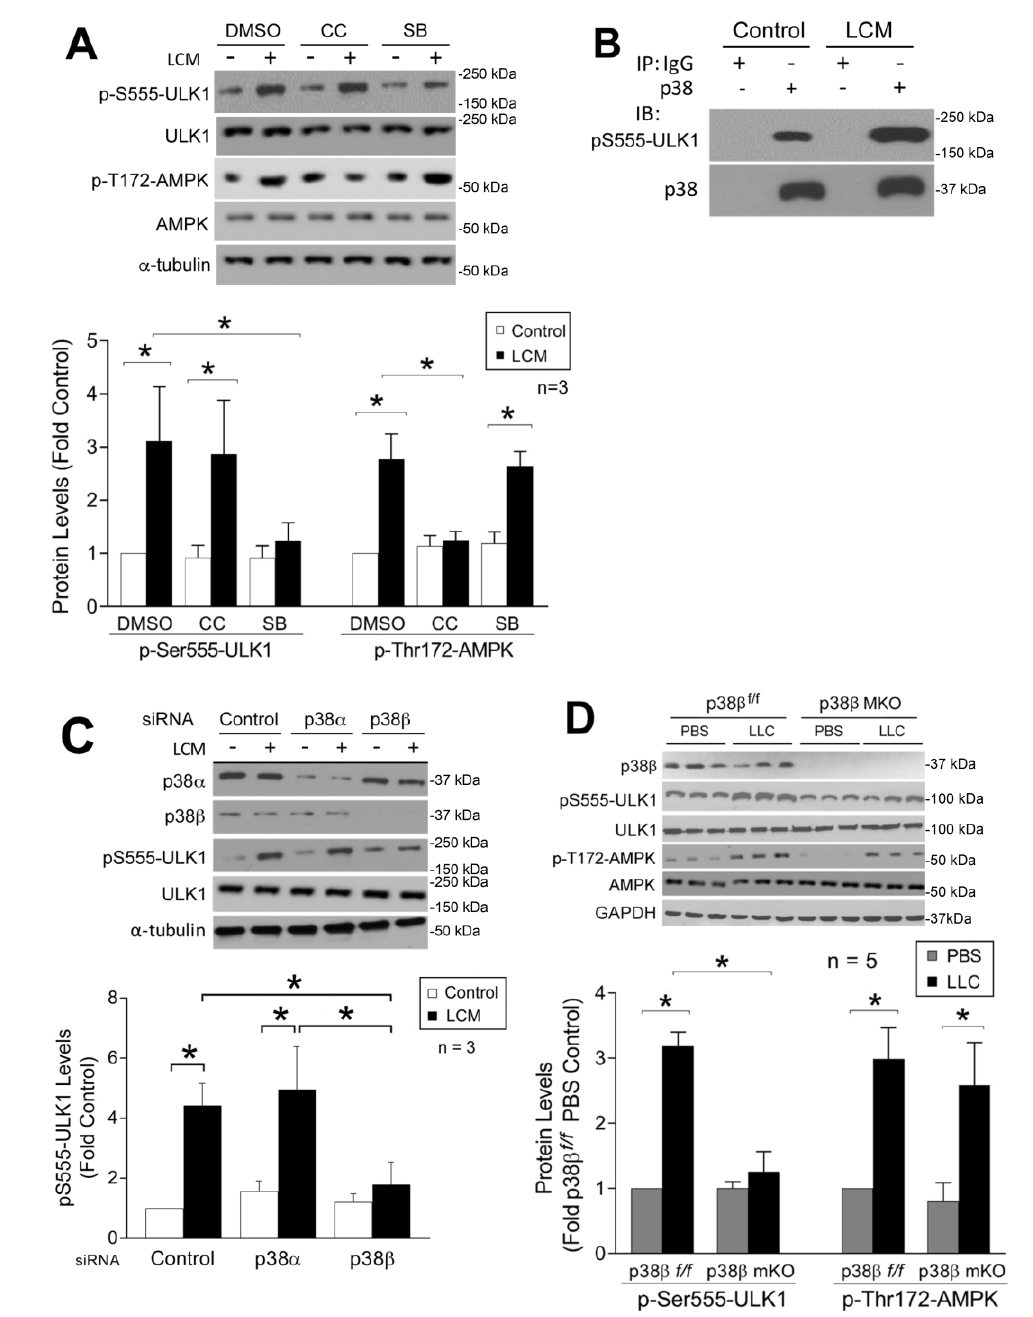
FIGURE 6: p38  MAPK activates ULK1 in skeletal muscle cells in response to tumor. (A) LCM stimulates ULK1 phosphorylation on Ser-555 in myotubes through p38 MAPK. C2C12 myotubes were pretreated with DMSO (0.1%, vehicle), compound C (CC, 10  M) or SB202190 (SB, 10  M) for 30 min, and then treated with LCM for 1 h. ULK1 phosphorylation state on Ser-555 and AMPK phosphorylation on Thr-172 in cell lysate were analyzed by Western blotting. (B) LCM stimulates p38 MAPK interaction with ULK1 in myotubes. C2C12 myotubes were treated with LCM for 1 h. Cell lysate was subjected to immunoprecipitation with pre-immune IgG or p38 MAPK-specific antibody. Precipi- tate was analyzed by Western blotting for p38 MAPK and pSer-555 ULK1. (C) LCM stimulation of ULK1 phosphorylation on Ser-555 in myo- tubes is mediated by p38  MAPK specifically. C2C12 myoblasts were transfected with control, p38  MAPK or p38  MAPK-specific siRNA. After differentiation for 96 h, myotubes were treated with LCM or control medium for 1 h. Knockdown of p38 MAPKs and phosphorylation of ULK1 on Ser-555 were analyzed by Western blotting. (D) p38  MAPK is required for ULK1 activation in cachectic muscle of LLC tumor- bearing mice. Mice with muscle-specific knockout of p38  MAPK and control mice were implanted with LLC cells. Lysate of TA collected from these mice on day 21 was analyzed by Western blotting for ULK1 phosphorylation on Ser-555 and AMPK phosphorylation on Thr-172. Data were analyzed by one way AVOVA. * denotes a difference (p <